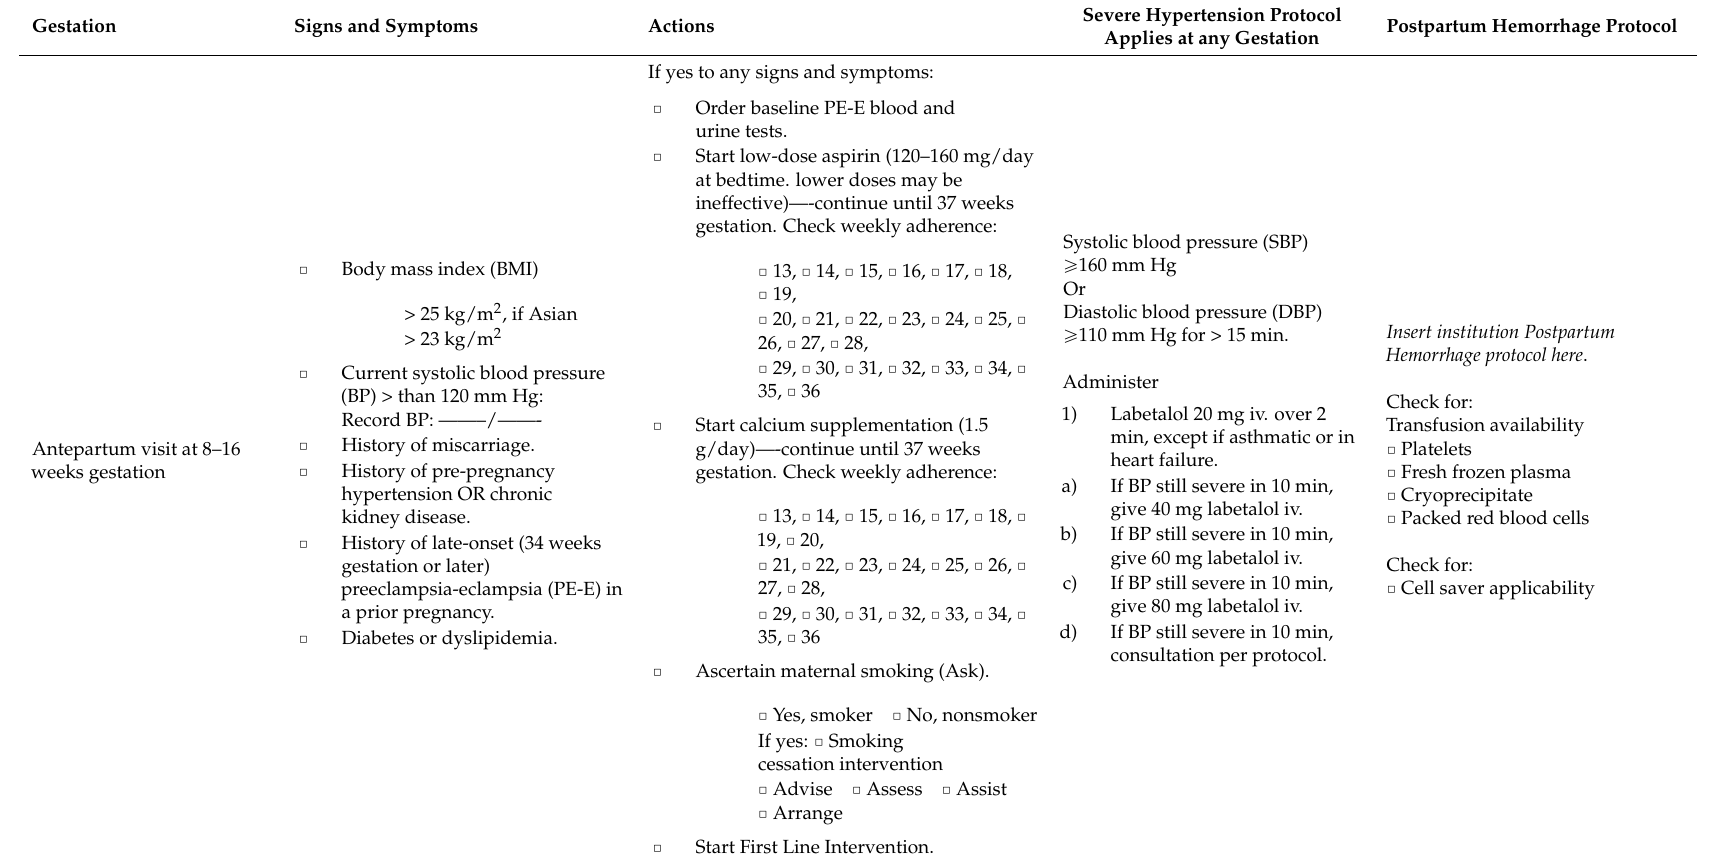
Table 2. Preeclampsia-eclampsia (PE-E) checklist. ( A ) First and second trimester record; ( B ) Second and third trimester record; ( C ) Term and fourth trimester record; ( D ) Outcome